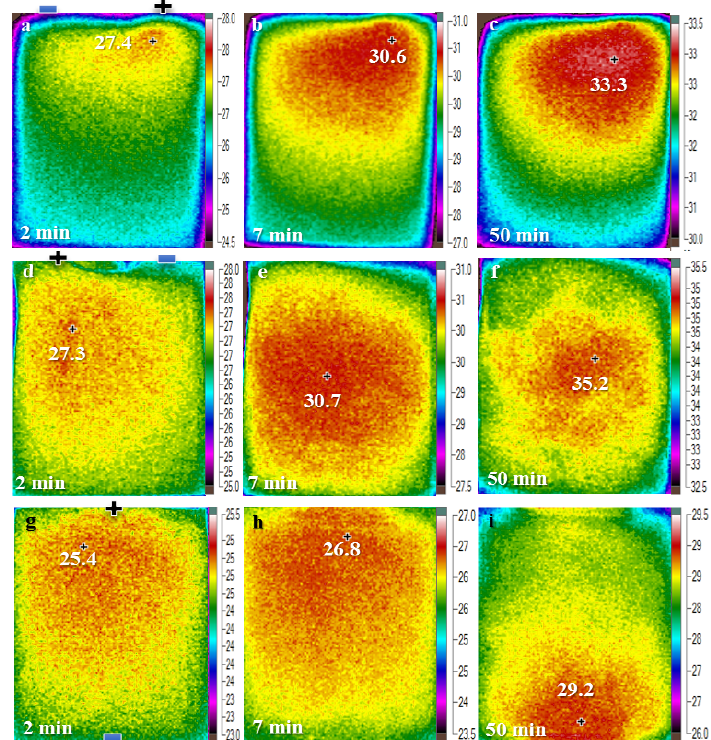
Figure 11. IR images during micro pulse cycling at 80 A of NMC, LFP and LTO cells at an 80% SoC at different points of time along with the location of respective maximum temperature. ( a ) NMC after 2 min; ( b ) NMC after 7 min; ( c ) NMC after 50 min; ( d ) LFP after 2 min; ( e ) LFP after 7 min; ( f ) LFP after 50 min; ( g ) LTO after 2 min; ( h ) LTO after 7 min; ( i ) LTO after 50 min. Different temperature scales were used here to show the distinguishable non-uniformity of surface temperature